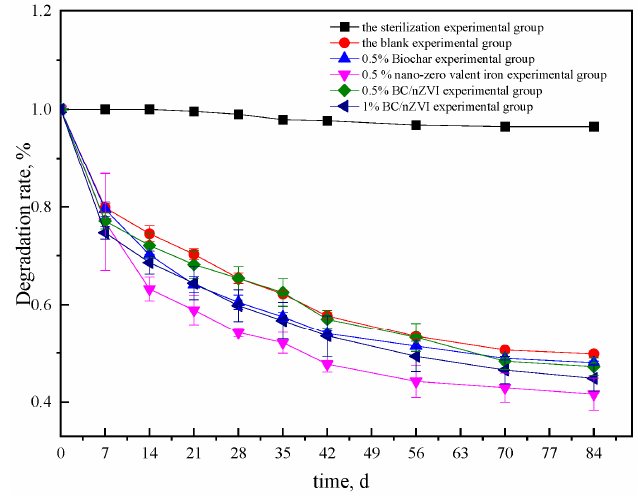
Figure 4. Effects of different experimental treatments on the degradation of α -HCH in soil.